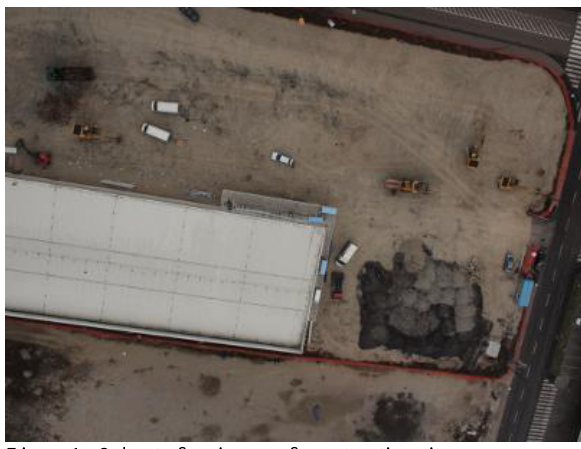
Figure 1. Subset of an image of construction site